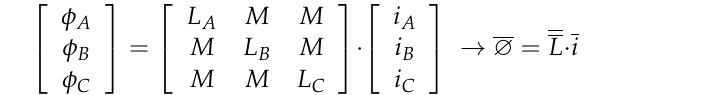
Figure 8. The 6/4 SRM prototype used to validate the mathematical model.